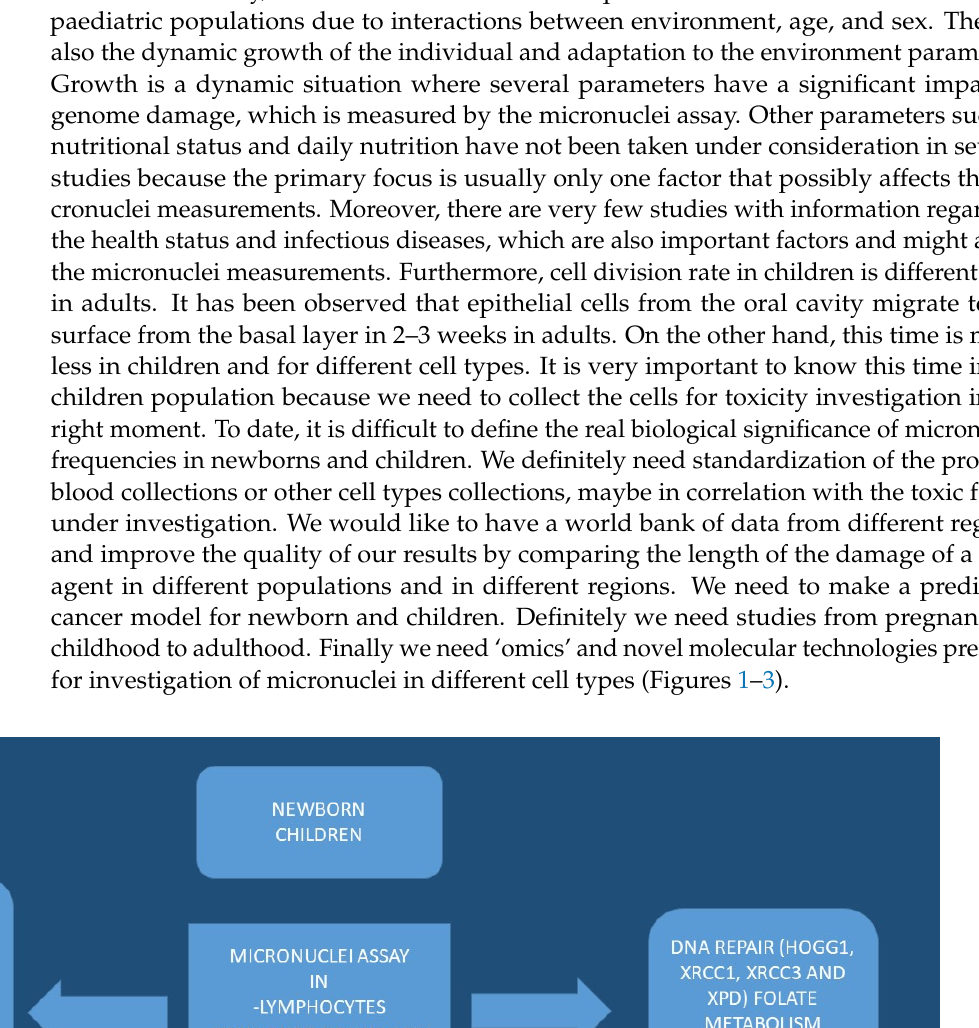
Figure 2. Damage to cellular DNA is involved in mutagenesis and the development of cancer. The DNA in a human cell undergoes a million damaging events per day, by both external (exogenous) and internal metabolic (endogenous) processes. Genomic mutations can also be carried over into daughter generations of cells if the mutation is not repaired prior to mitosis. Once cells lose their ability to effectively repair damaged DNA, there are three possible responses.